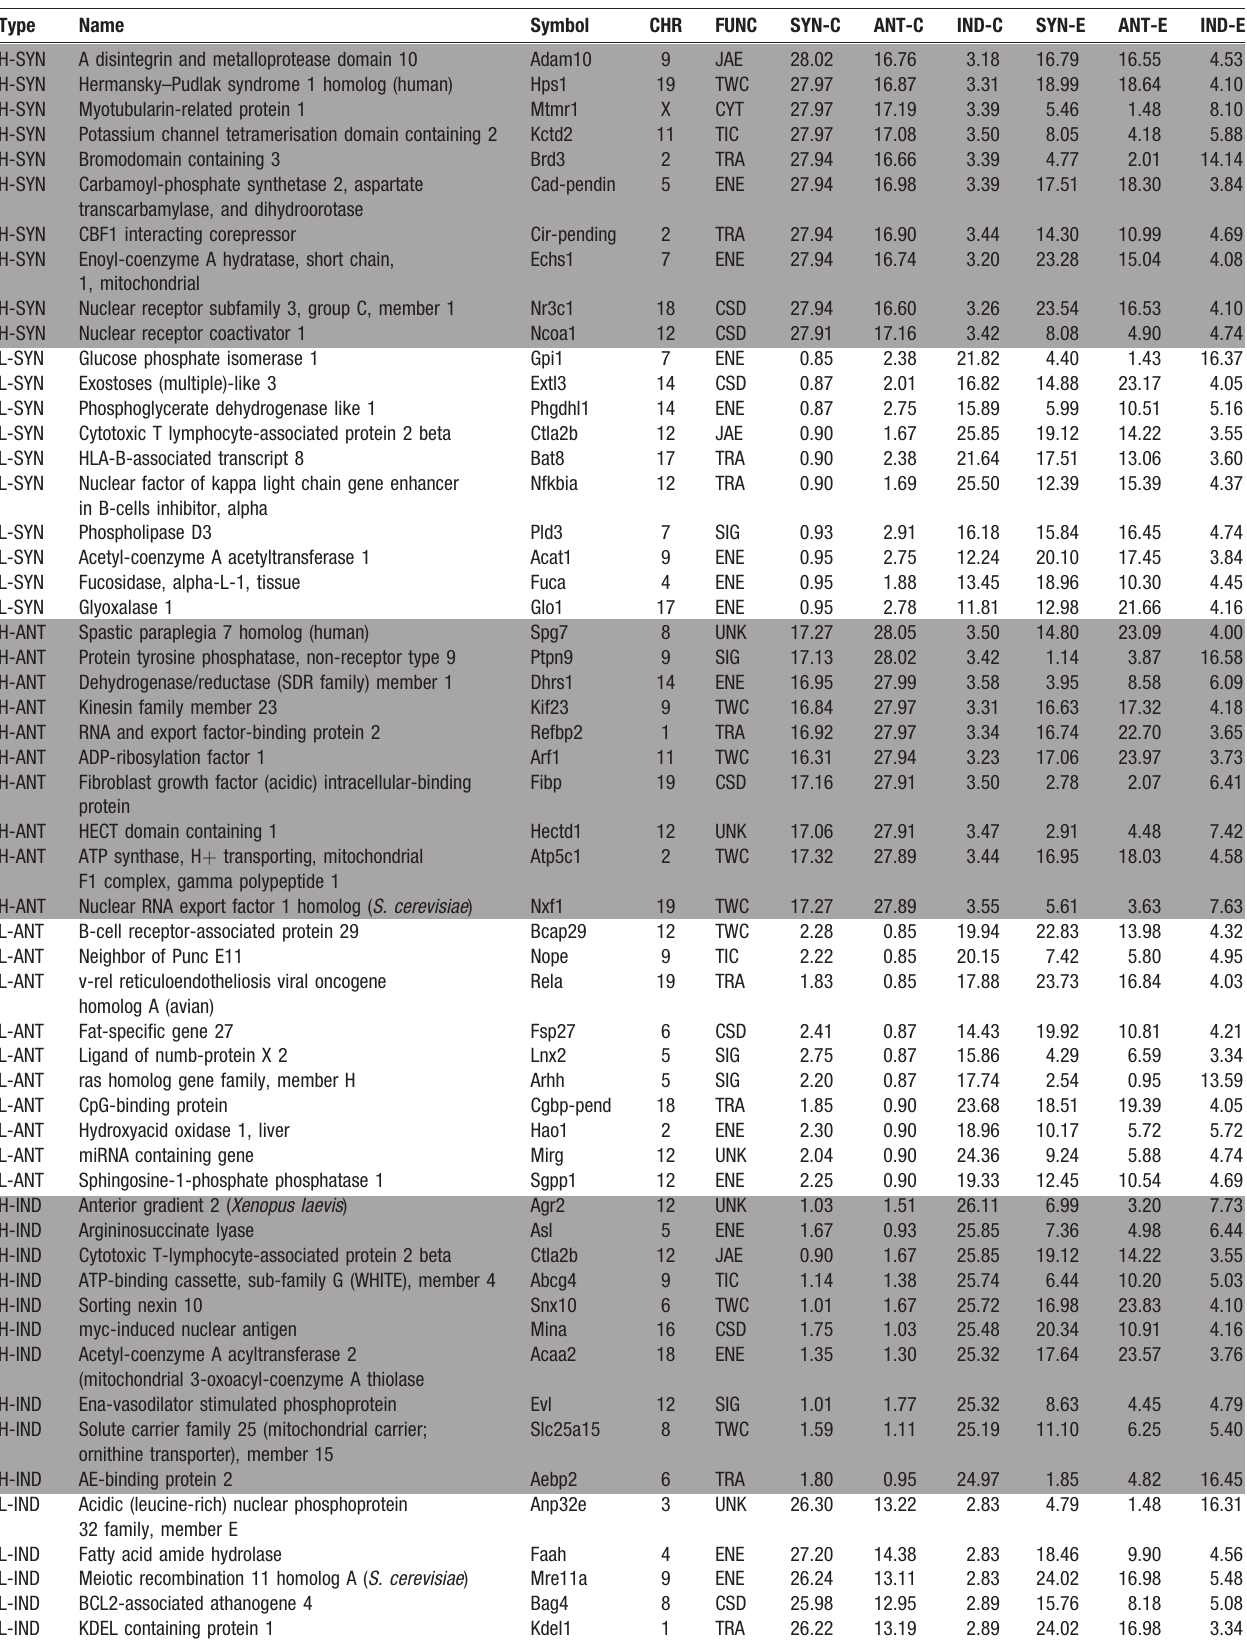
Table 4. Examples of genes with high (H) and low (L) percentages of synergistic (SYN), antagonistic (ANT), and independent (IND) expression partners within the control (C) spinal cord and the corresponding values for AT-EAE (E)